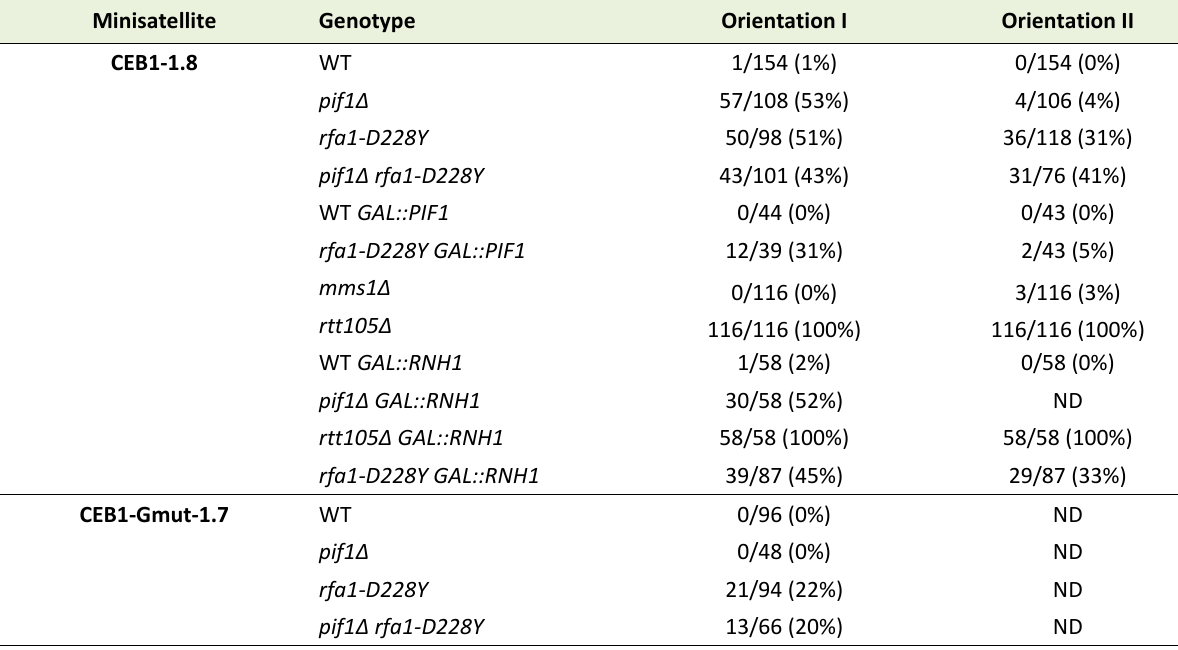
TABLE 1. Rearrangement frequencies of CEB1 placed near ARS305 in both orientations in WT and mutant